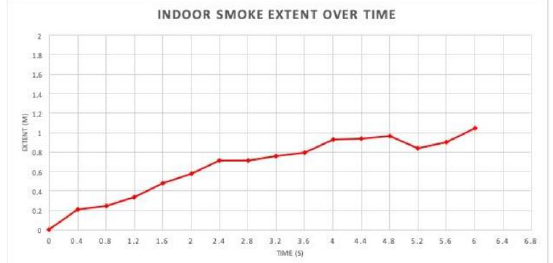
Figure 11. 2D Graph of Cigarette Smoke Extent vs Time in an Indoor Environment